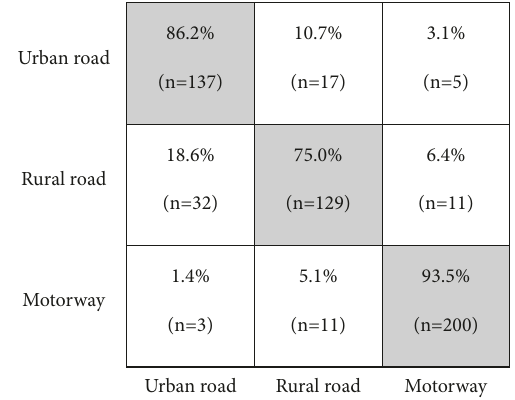
Figure 5: Confusion matrices of driving scenarios identification models using glance location